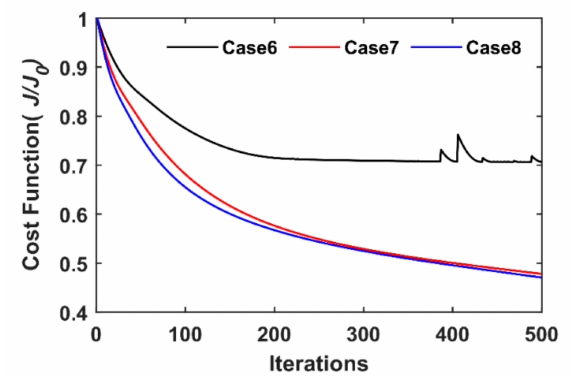
Figure 8. The cost functions of Cases 6–8.